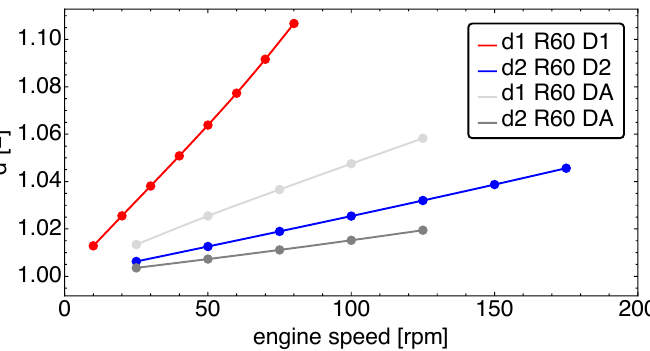
d Figure 4. The displacement ratios d 1 and 2 are shown as functions of the engine speed for the three engine designs D1, D2, and DA, and r = 0.6 regeneration extent. Note the strong increase of d 1 for the D1 design.